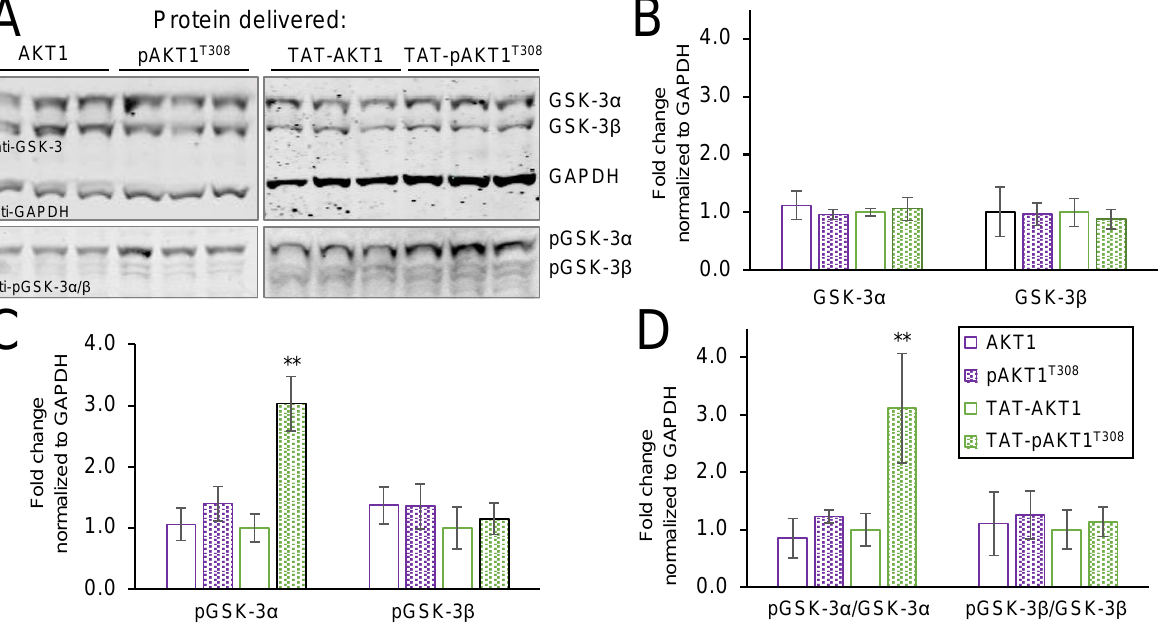
Figure 4. TAT-pAKT1 T308 protein delivery stimulates AKT1 signaling. HEK 293T cells were incubated with AKT1, pAKT1 T308 , TAT-AKT1, or TAT-pAKT1 T308 for 1 h in three biological replicates. ( A ) Cell extracts were separated by SDS-PAGE and immunoblotted with GSK-3, pGSK-3, and GADPH specific antibodies. GSK-3 homologs GSK-3 α and GSK-3 β are direct substrates of AKT1. ( B ) Quantification of western blots showed no change in GSK-3 α or GSK-3 β protein abundance. Changes in phosphorylation of GSK-3 α or GSK-3 β were quantified and normalized to ( C ) GAPDH or ( D ) GSK-3 α and GSK-3 β , respectively, showing that TAT-pAKT1 T308 specifically stimulates phosphorylation of GSK-3 α , but not GSK-3 β . Significant differences were calculated by two-tailed t -test and are indicated by asterisks (** p <